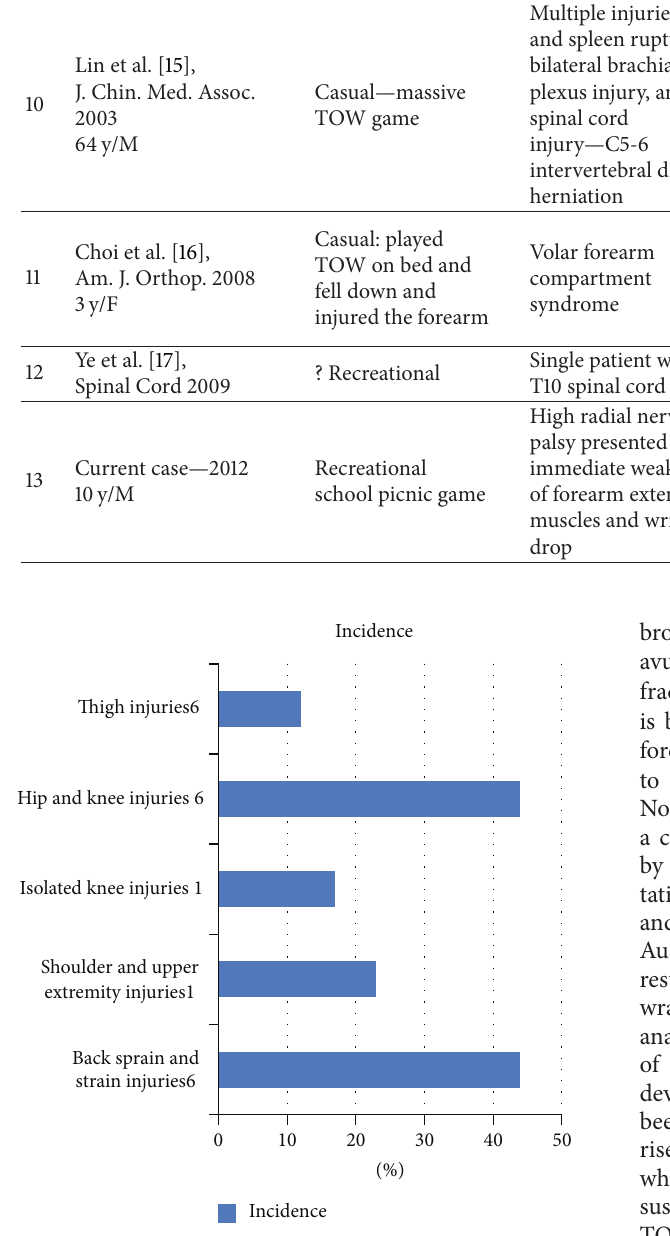
Figure 3: Common types of tug-of-war injuries [1,